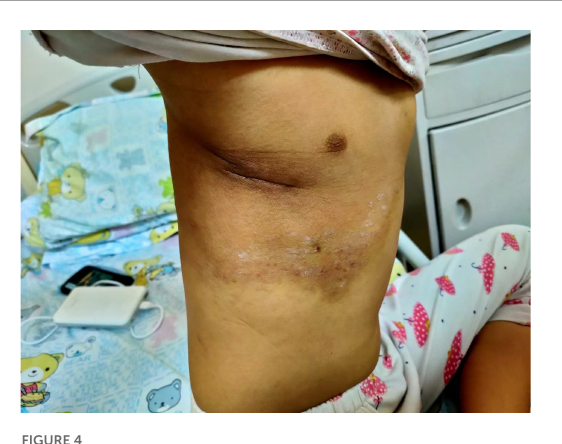
FIGURE4 Photo of the child on the 4th postoperative day.